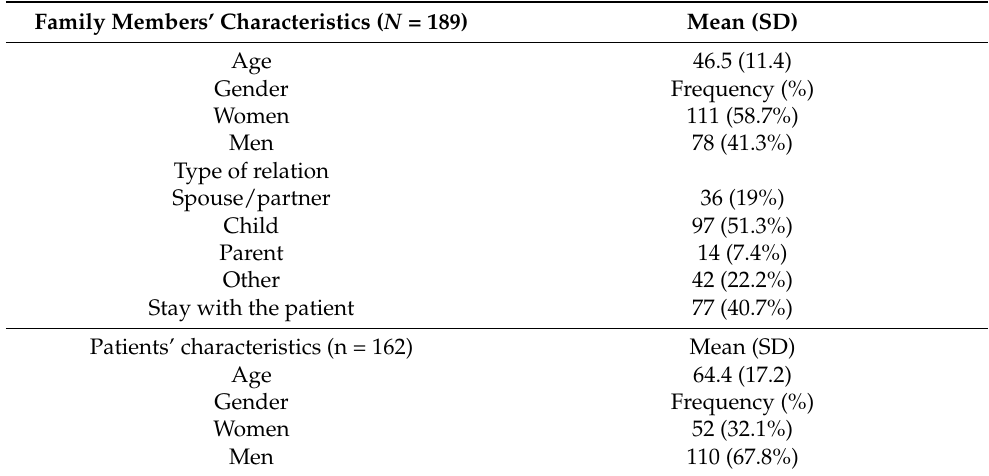
Table 1. Family members’ and patients’ characteristics.